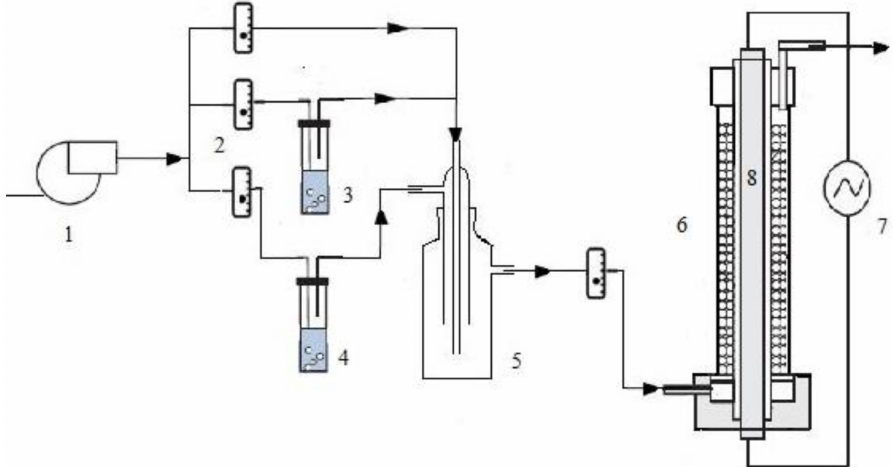
Figure 13. Schematics of the photocatalytic reaction system: ( 1 ) air pump, ( 2 ) rotameters, ( 3 ) humidifier, ( 4 ) ethylbenzene saturator, ( 5 ) mixing tank, ( 6 ) photoreactor, ( 7 ) power supply, ( 8 ) light